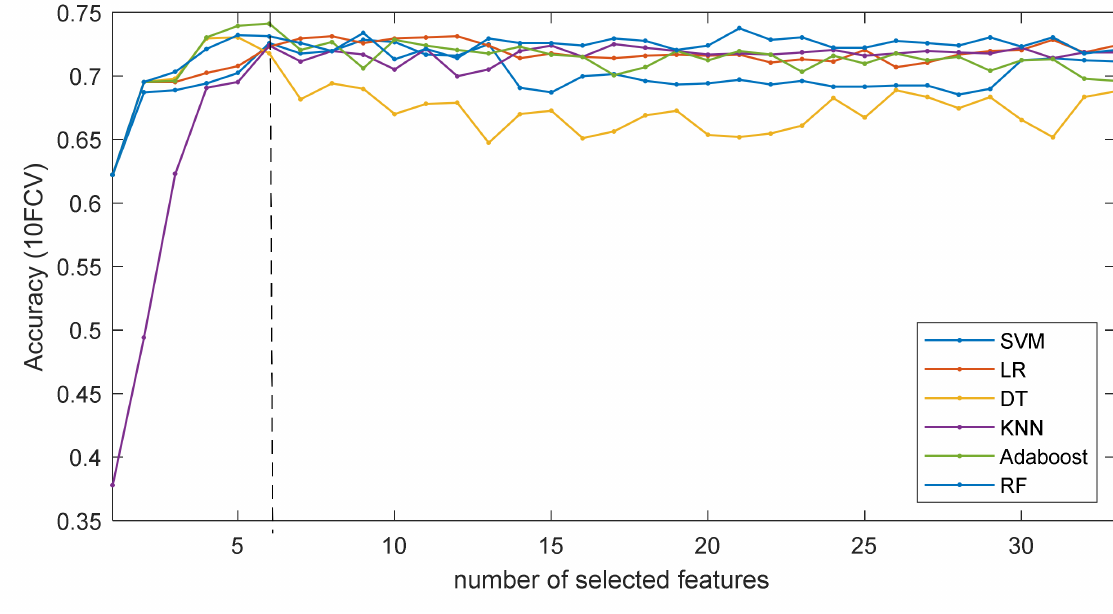
Figure 1. Accuracy with respect to the number of selected features for all the competing algorithms. Table 3. Statistical analysis of the selected features with respect to the outcome (presence of